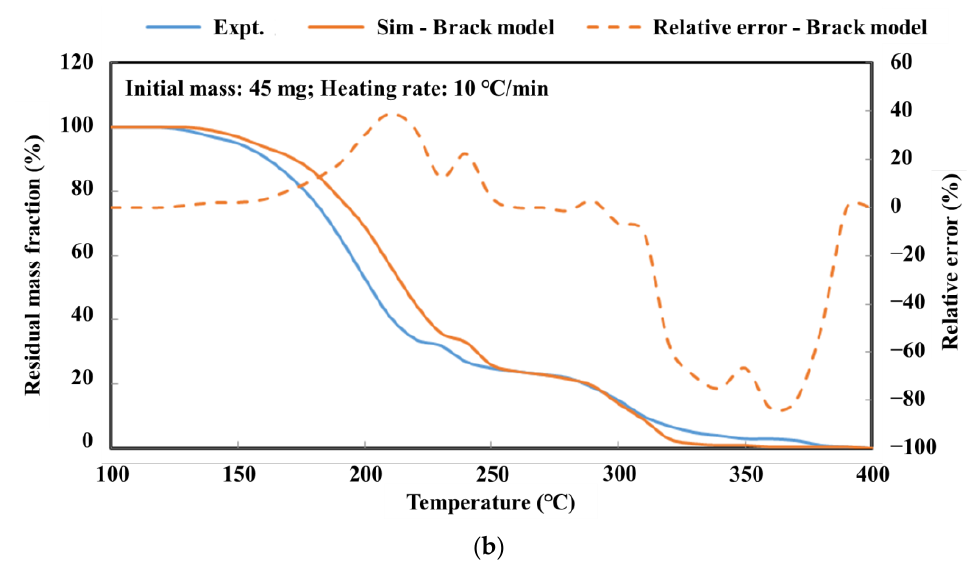
Figure 1. Experimental and simulation results comparison of urea pyrolysis ( a ) Comparison result of Ebrahimian model ( b ) Comparison result of Brack model.